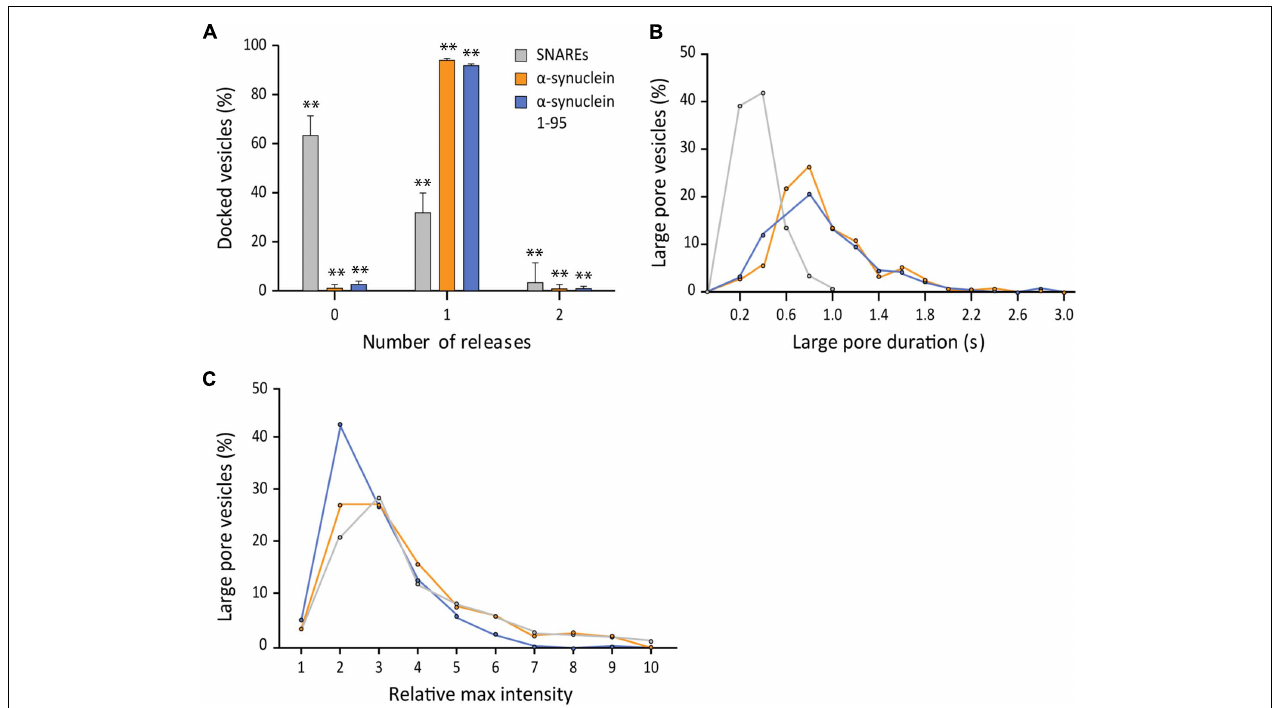
FIGURE 5 | The SNARE interaction with α S does not affect fusion pore expansion. (A) Distribution of number of large pore fusion events for individual docked vesicles. For α S 1-95, events from 5 independent measurements were analyzed for A–C . Error bars represent standard deviations from means. The data are shown as means ± SD. ∗∗ p < 0.01 by Student’s t -test; n = 3 independent experiments. (B) Distribution of the duration of the large fusion pore. (C) Distribution of relative maximum intensities of large pore fusion